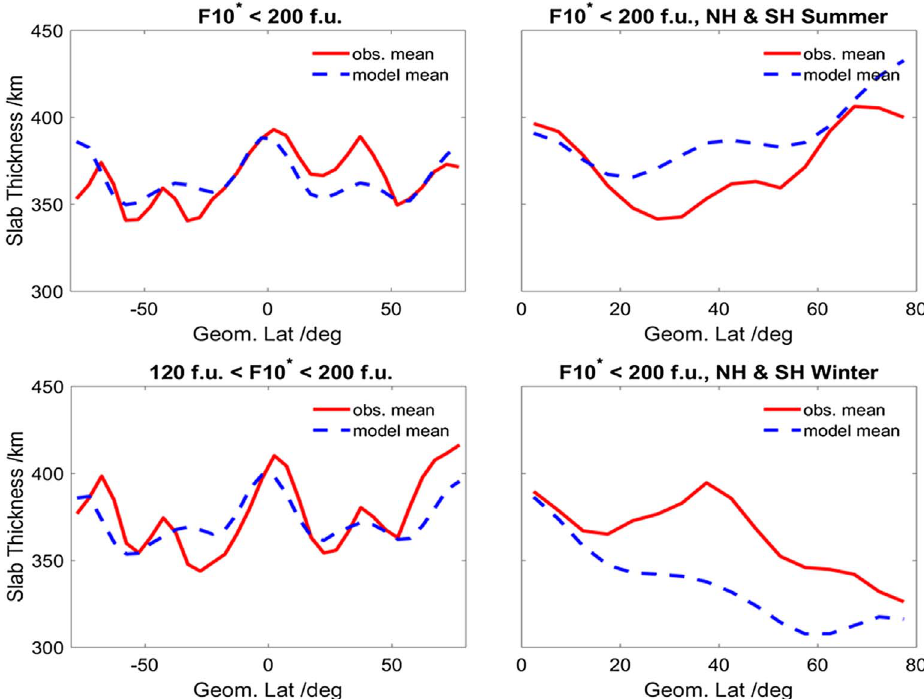
Fig. 14. Variation of the equivalent slab thickness as a function of the geomagnetic latitude (solid red line) in comparison with model values (dashed blue line). Left side: overall data (top) and excluding LSA data (bottom), right side: separated data for summer and winter conditions including both hemispheres.